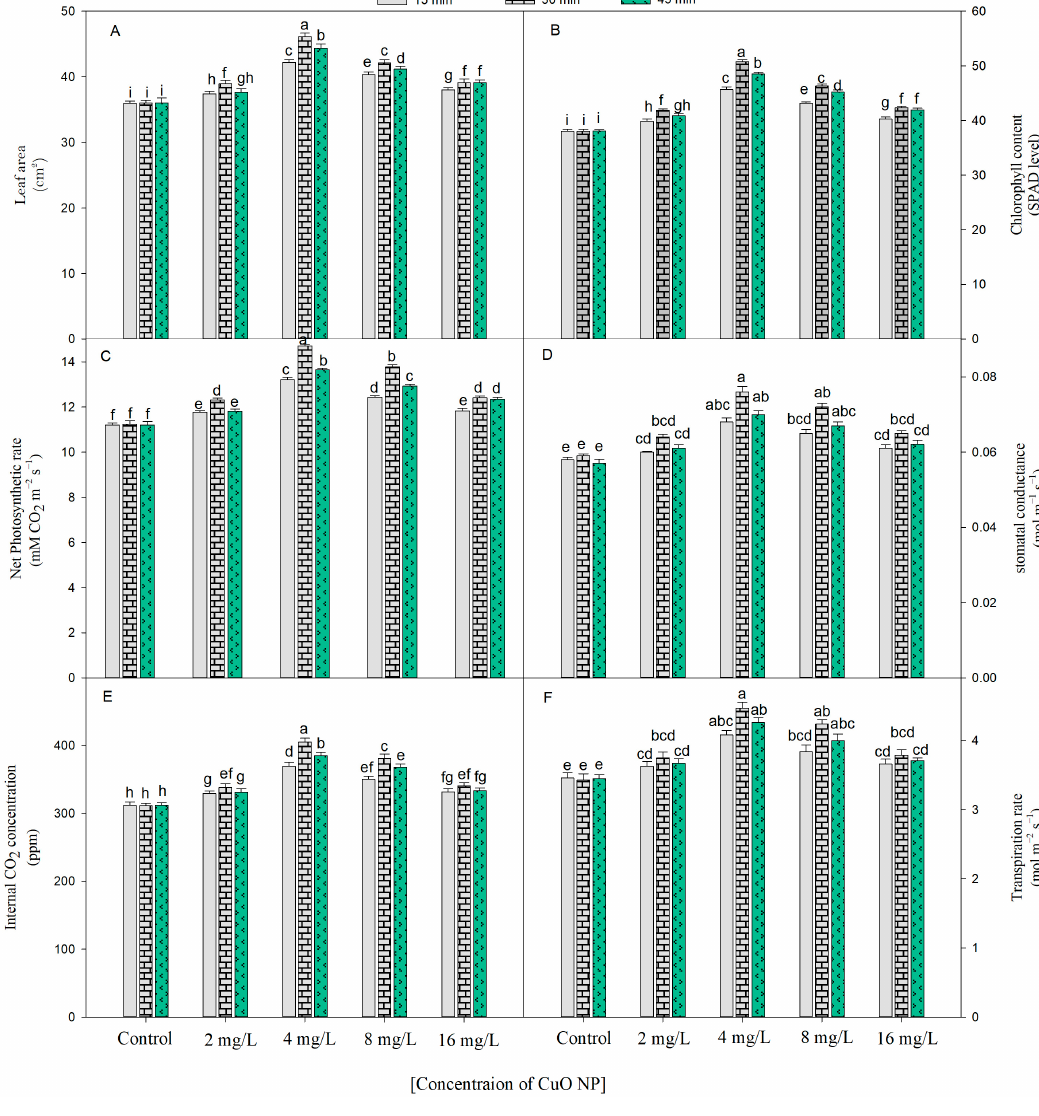
Figure 2. This figure depicts the outcome of CuO NPs on the leaf area ( A ) and SPAD value of chlorophyll ( B ), net photosynthetic rate ( C ) and stomatal conductance ( D ), internal CO 2 concentration ( E ), and transpiration rate ( F ) of Brassica juncea at 45 DAS. The entire set of data shows the average of five replicates ( n = 5); significant differences between control and treatment and among treatment were represented by different letters and standard error (±SE) was represented by vertical bars.